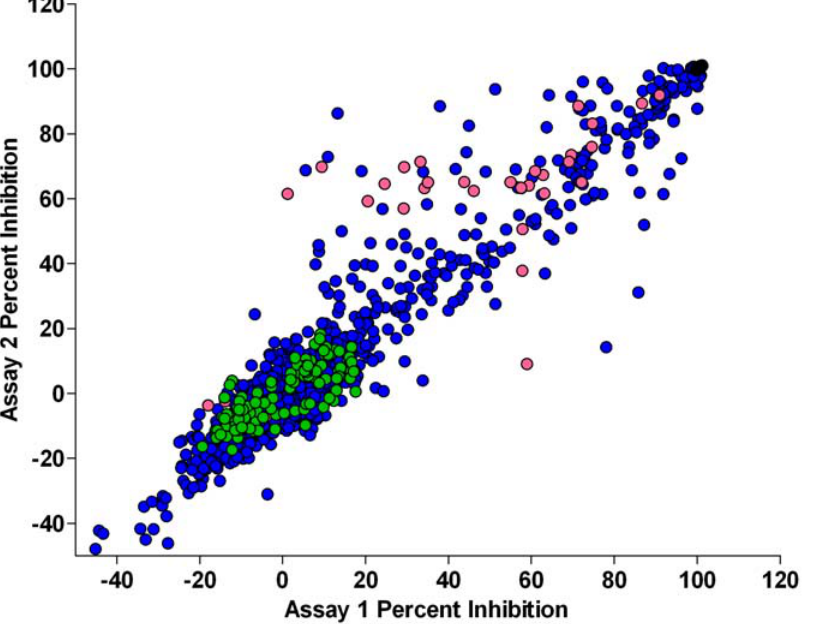
Figure 1. Reproducibility of the automated assay format demonstrated with the Library of Pharmacologically Active Compounds (LOPAC). The robustness of the L. major promastigote drug susceptibility assay was demonstrated by screening the 1,280 compound LOPAC library in duplicate at 10 m M. The reproducibility between the two assays was R 2 =0.94. Average Z-factors equaled 0.71 6 0.03 with a signal to background (S:B) ratio of 20.98 6 0.32. (blue circle - test compound; green circle - MAX control; red circle - MIN control; and pink circle - EC 50